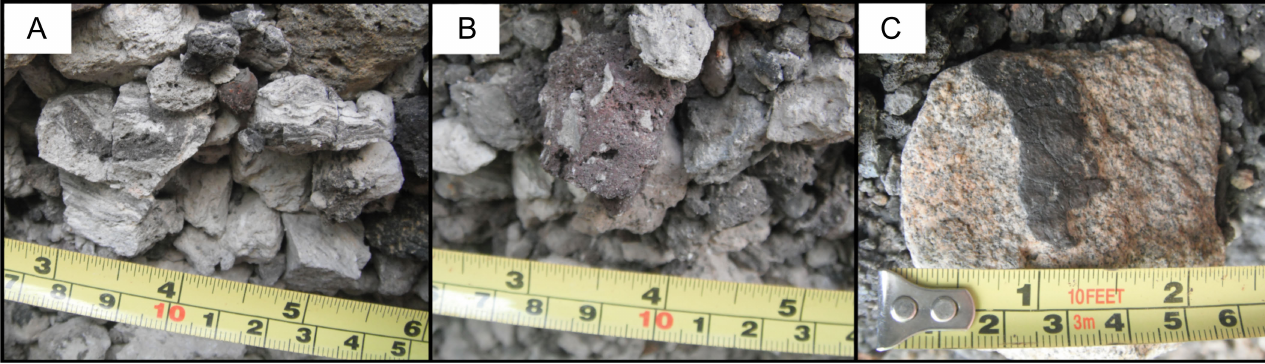
Figure 3: Clasts of the mingled fall deposit. [A] Mingled felsic clasts from subunit L2B; [B] Mingled scoria clasts from L3; [C] Mafic volcanic rock-coated plutonic clast from subunit L3. Tape measure shows distances in inches (top) and centimetres